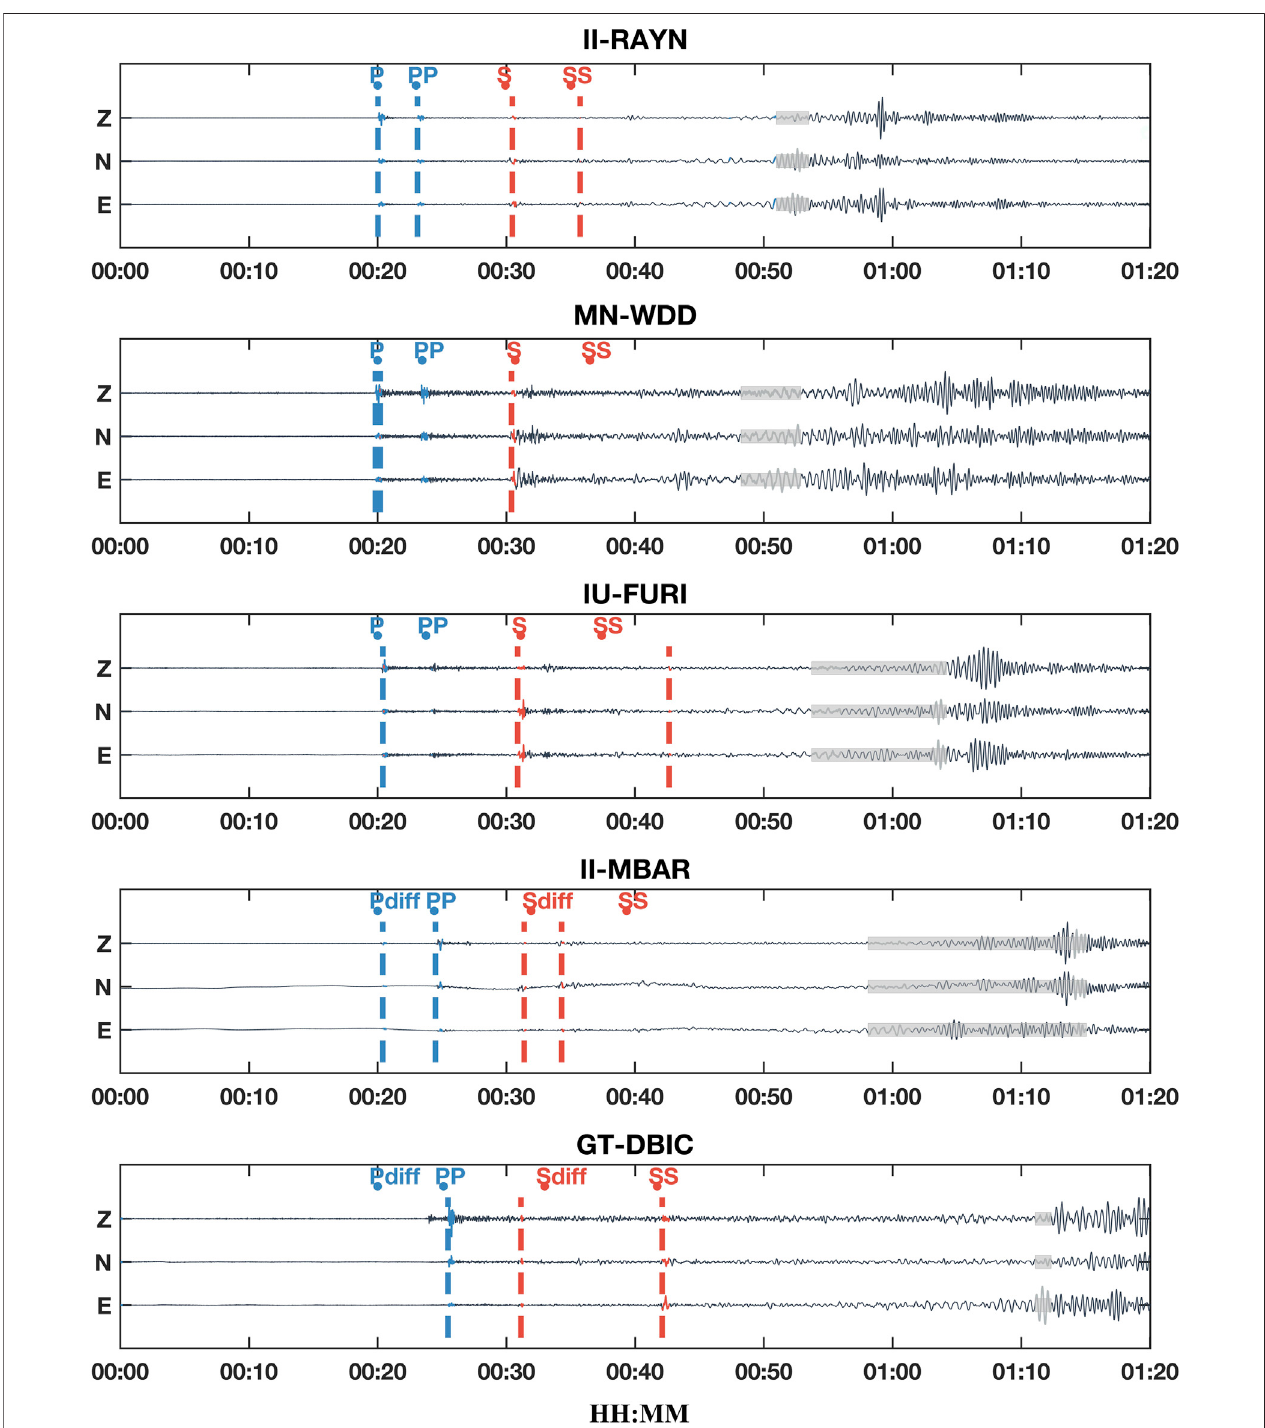
FIGURE 3 | Phase detection using polarization analysis applied to data recorded at the fi ve high-quality stations during the Hokkaido event of September 5, 2018. Thewaveformsareforan80 min-longtimewindow, wheretime0:00is20 minbeforetheParrivalateach stationfollowingtheeventorigin.Thedetected arrivalofPand S waves is marked with blue and red dashed lines, respectively, while the fi rst arriving linearly polarized surface wave is shaded in gray. The predicted arrival time calculated using the earthquake parameters and an earth model is indicated with dots and labels indicating the phase.